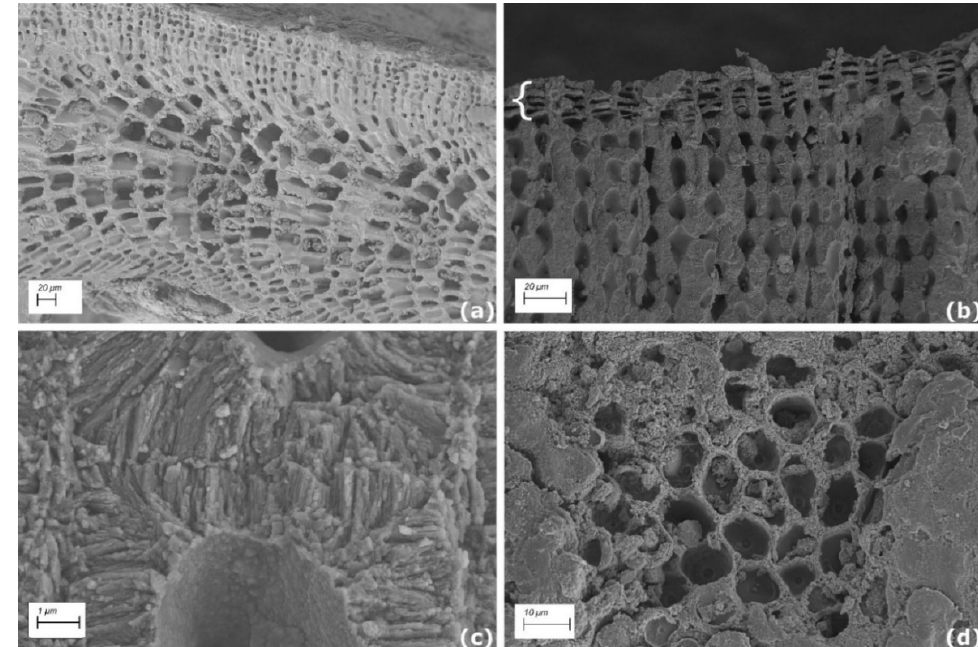
Figure 1. SEM images showing: ( a ) a longitudinal section through Mesophyllum philippii coaxial hypothallus assigned to the hypothallus category; ( b ) a longitudinal section through Lithophyllum racemus epithallus (curly bracket) with the underlying perithallus assigned to both perithallus and epithallus categories; ( c ) a magnification of L. racemus perithallial cells showing crystallites composing the cell walls (crystallites category); ( d ) a Lithophyllum pseudoracemus sample in surface view (surface